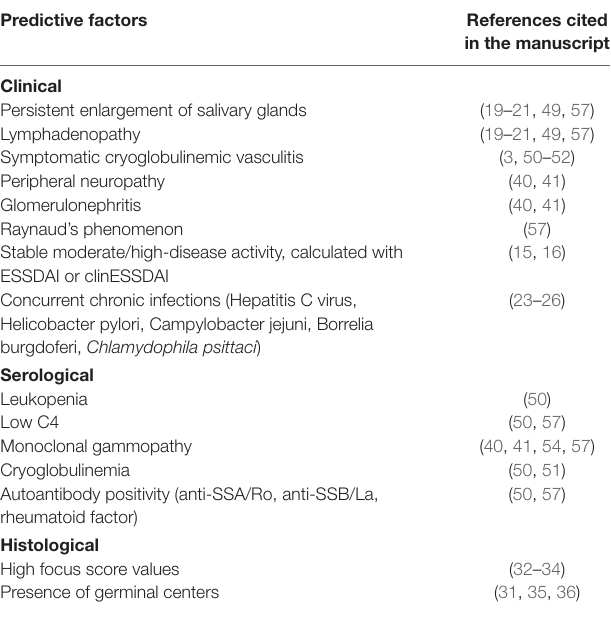
TAbLe 1 | Classical clinical, serological, and histological predictors of lymphoma development in primary Sjögren’s syndrome. Predictive